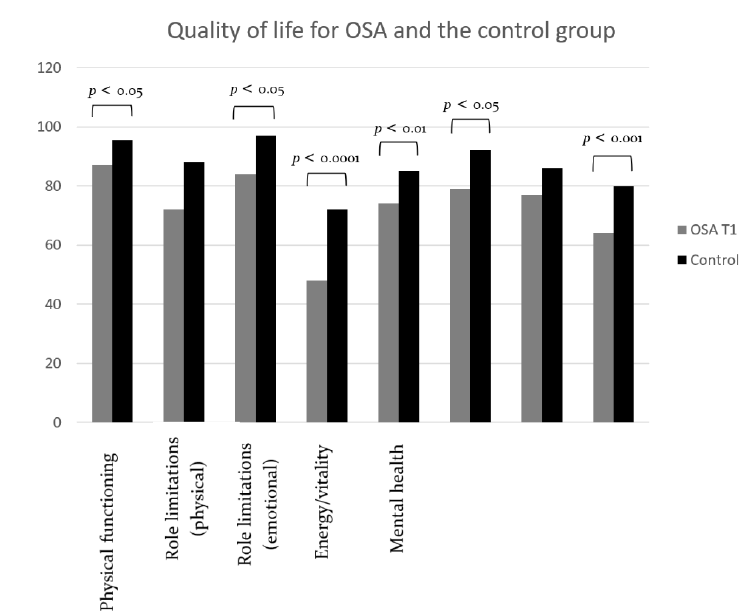
Figure 2. Difference in daytime sleepiness between the OSA group and the control group before MAD treatment (T1) and before (T1) and after (T2) MAD treatment in the OSA group. Significant differences are shown with lines and p values.